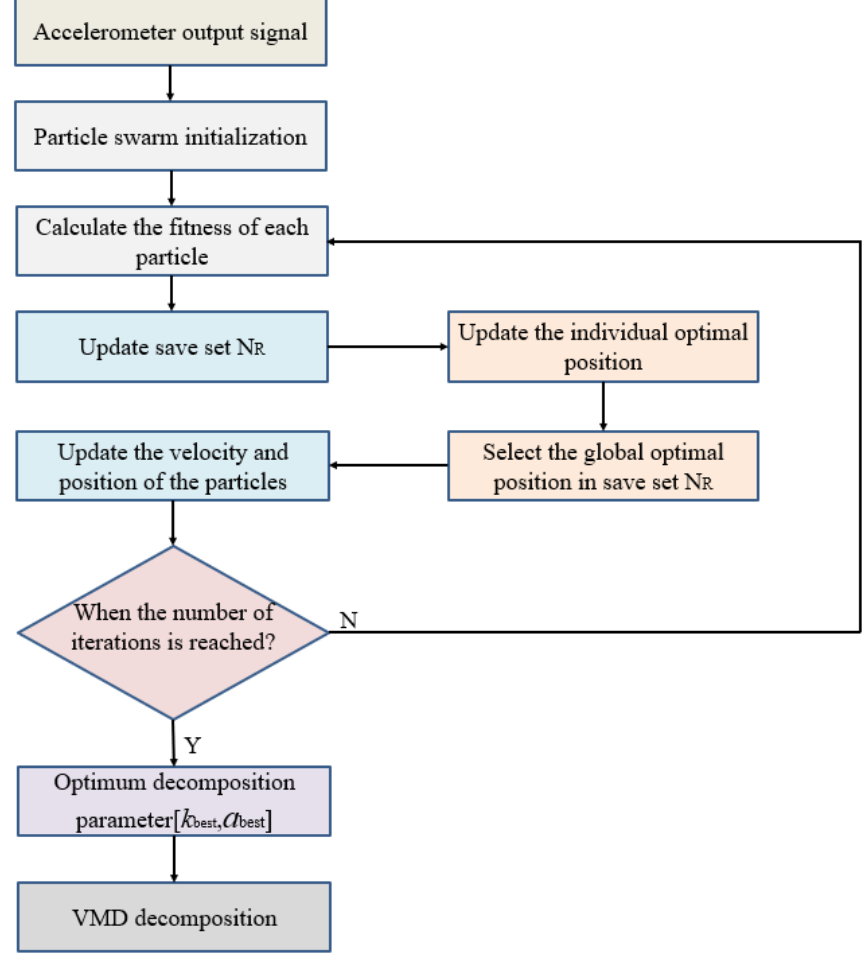
Figure 1. The flow diagram of the improved VMD.